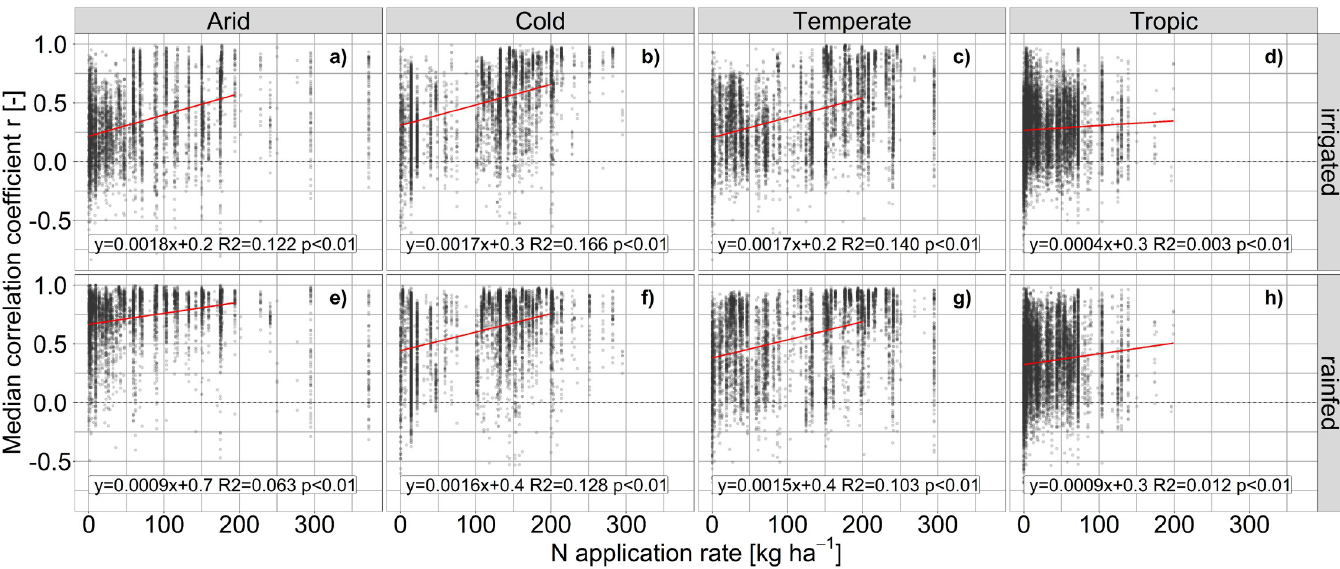
Fig 6. Median time-series correlation coefficient r for maize yields among EPIC-based GGCMs compared to fertilizer application rates. Results are shown for the fully harmonized management scenario (fullharm) with sufficiently irrigated (a-d) or rainfed (e-h) water supply in each grid cell of four major climate regions. Linear regressions are limited to � 200 kg N ha -1 , which commonly corresponds to sufficient N supply